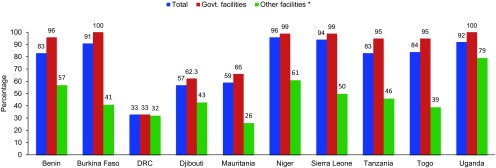
Percentage of Health Facilities Providing Family Planning Services, by Type of FacilityAbbreviation: DRC, Democratic Republic of the Congo.* “Other facilities” includes all health care providers not managed by the government, including private sector, faith-based organizations, NGOs, and other similar organizations.